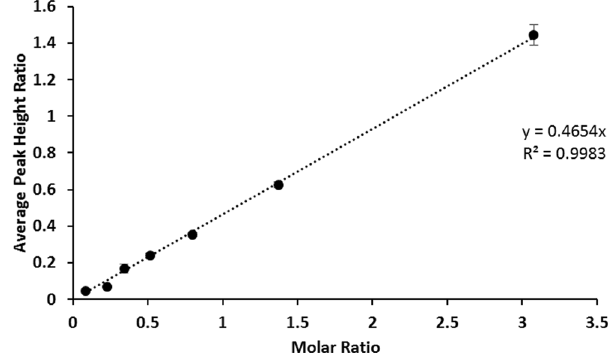
Figure 1. Average peak height ratio for the (020) Brushite peak vs the (002) HAP peak versus the molar ratio of HAP: Brushite, n = 10. R 2 =